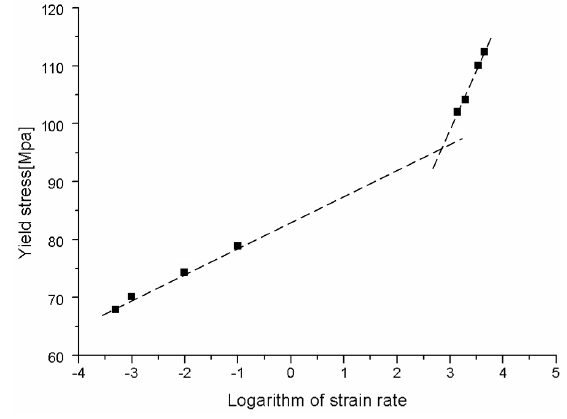
Figure 8. Yield stress of PC over a wide range of strain rates.